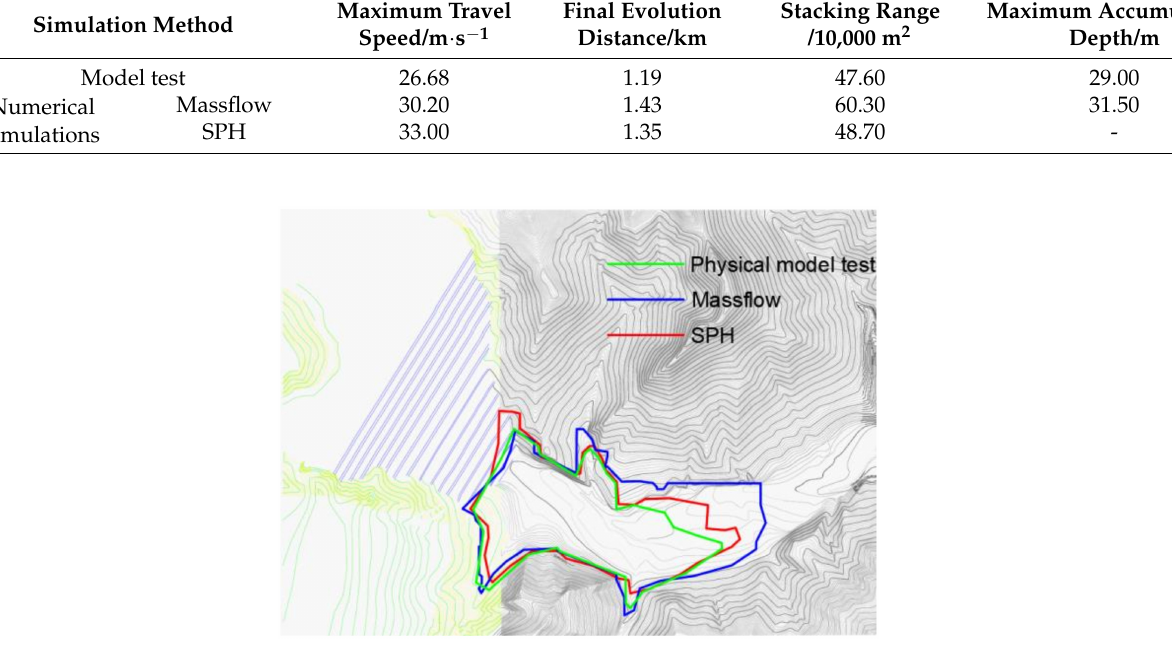
Figure 18. Range of tailing sand accumulation given by different